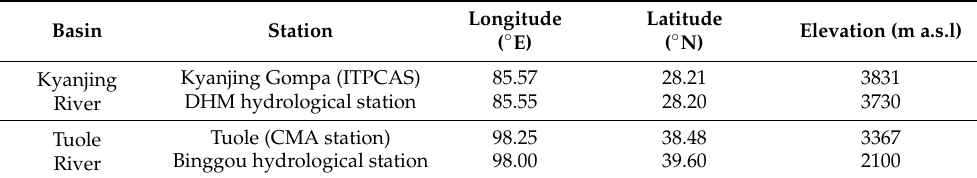
Figure 1. The location of the Kyanjing and Tuole River basins in the Tibetan Plateau ( a ). While the Yala Glacier is located in the Kyanjing basin ( b ), the Qiyi Glacier is located in the Tuole basin ( c ). The red and black squares in ( b , c ) show the locations of meteorological and hydrological stations. Table 1. The location information for meteorological and hydrological stations at the Tuole River and Kyanjing River.